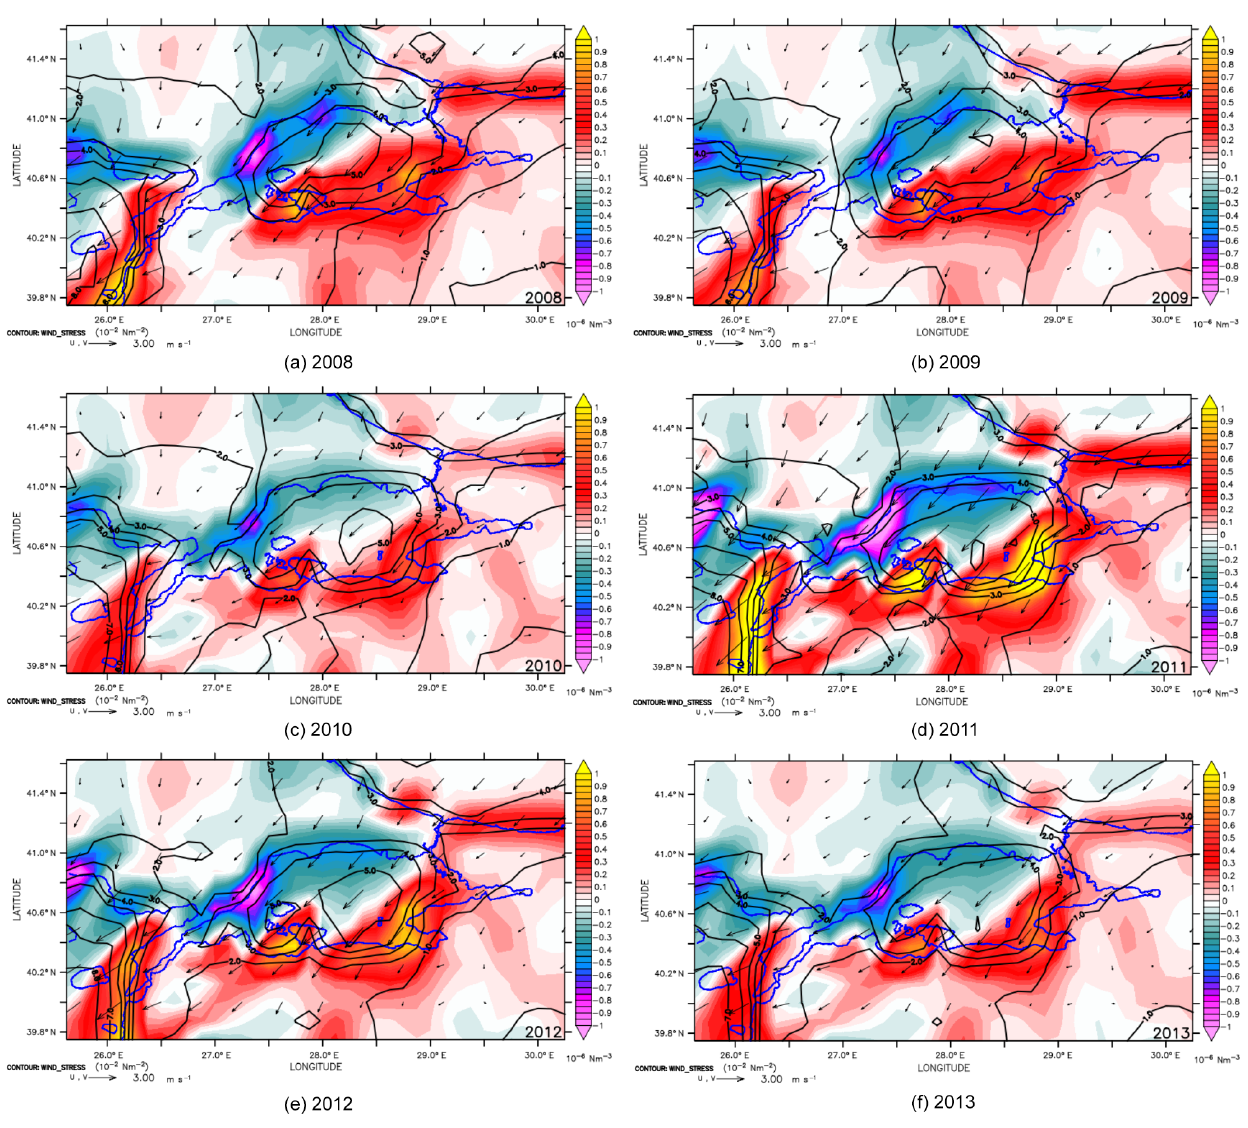
Figure 2. Annual mean of wind velocity (ms − 1 , arrows), wind stress (10 − 2 Nm − 2 , black contours) and wind stress curl (10 − 6 Nm − 3 , shades) in the Sea of Marmara for each year from 2008 (a) to 2013 (f) . The coastline is overlaid in